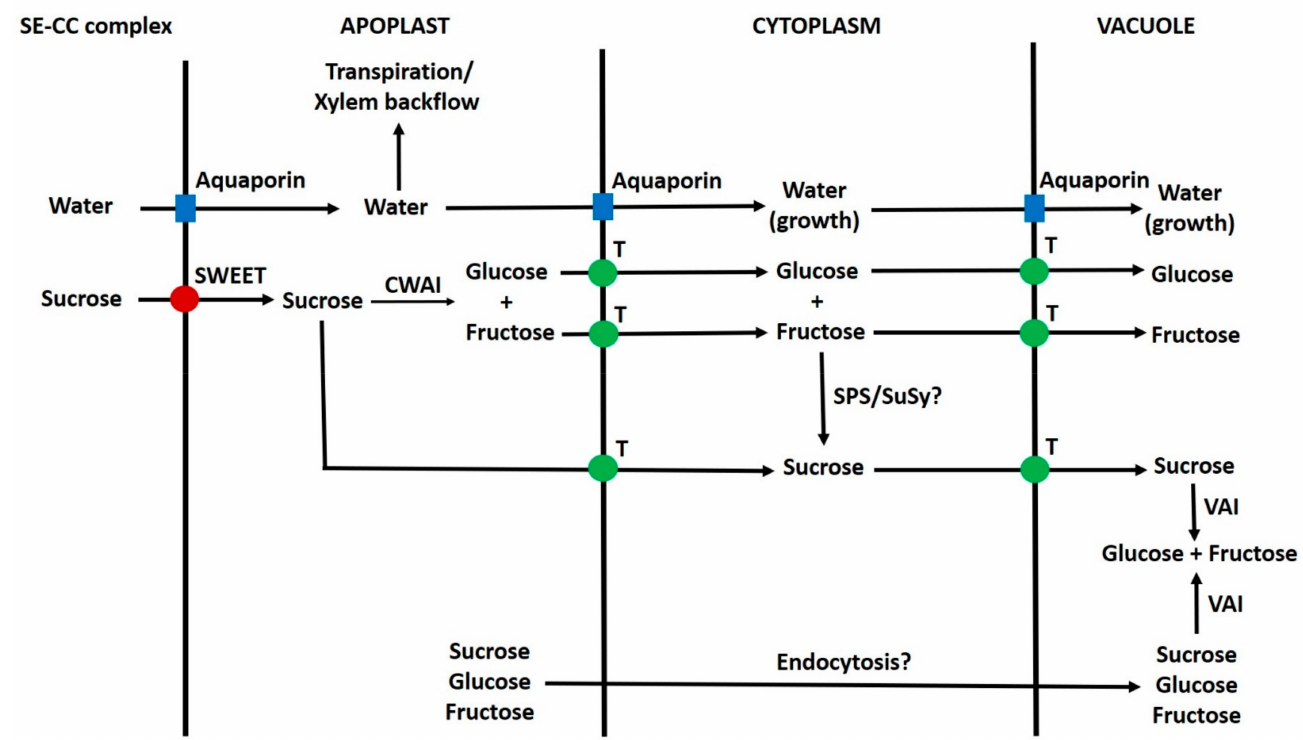
Figure 4. Sucrose transport and associated metabolism in grape pericarp during ripening. Sucrose exits the SE-CC complex via a SWEET, then a proportion of sucrose is hydrolysed by CWAI. Sugars then move through the apoplast, and this movement can be brought about largely by transpiration. Sugars can potentially enter parenchyma cells and move to the vacuole by several pathways. The contribution of each pathway is unknown. Aquaporin water channels enable a rapid osmotically driven bulk flow of water. Abbreviations: CWAI = cell wall acid invertase; SE-CC = sieve element-companion cell; SuSy = sucrose synthase; SPS = sucrose phosphate synthase; SWEET = sucrose will eventually be exported transporter; T = sugar transporter; VAI = vacuolar acid